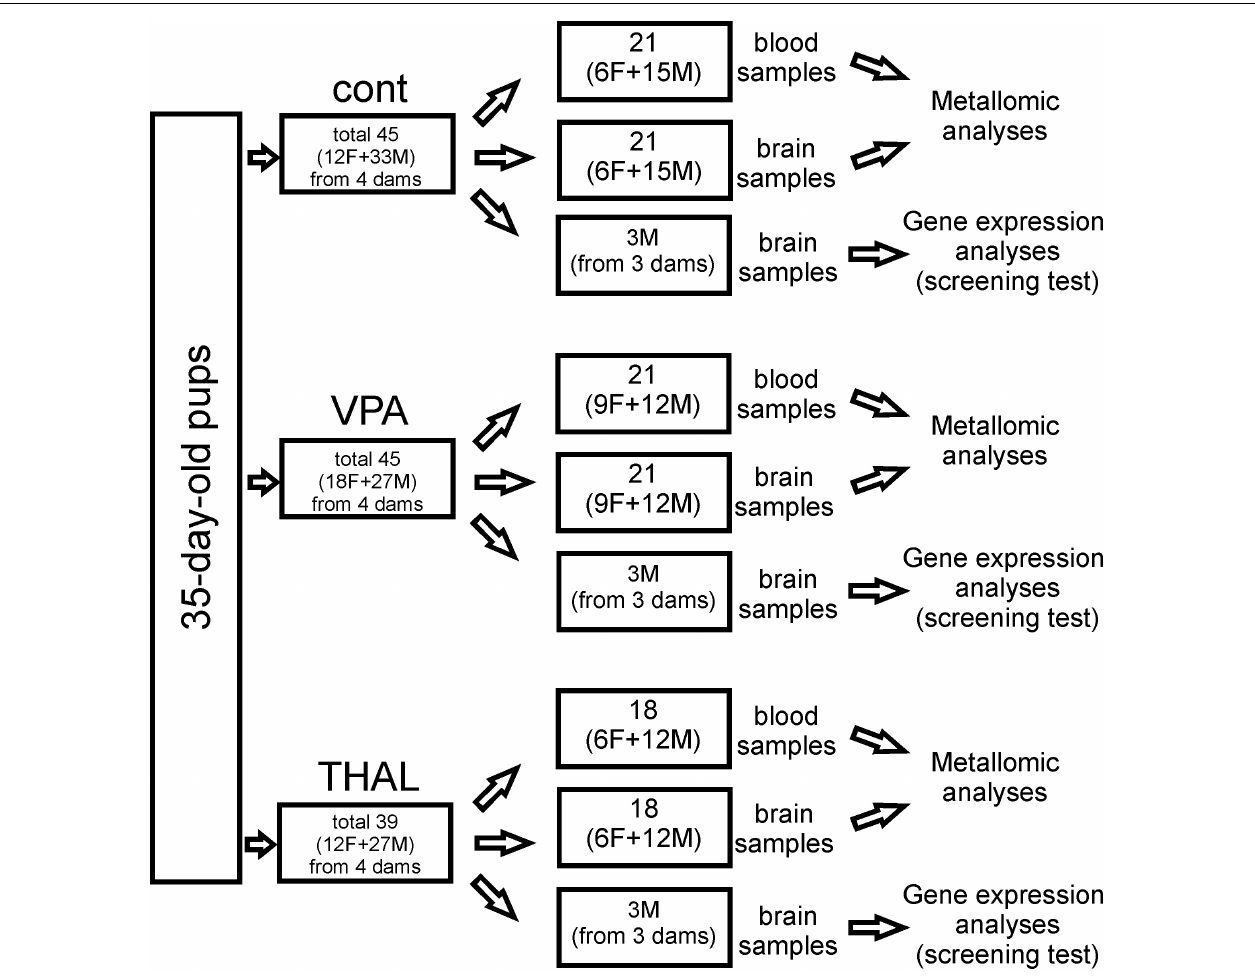
FIGURE 1 | Cont – control group, VPA – valproate group, THAL – thalidomide group, F – female, M – male.